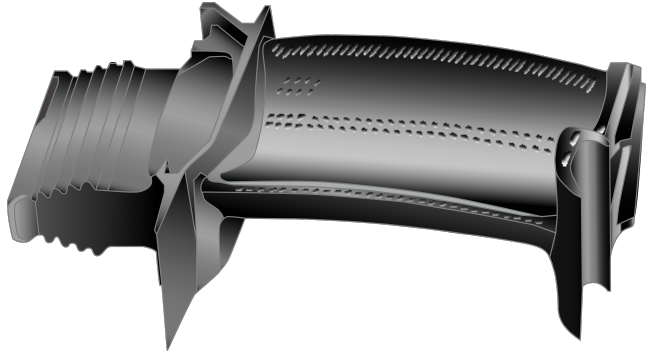
Figure 2. New turbine blade